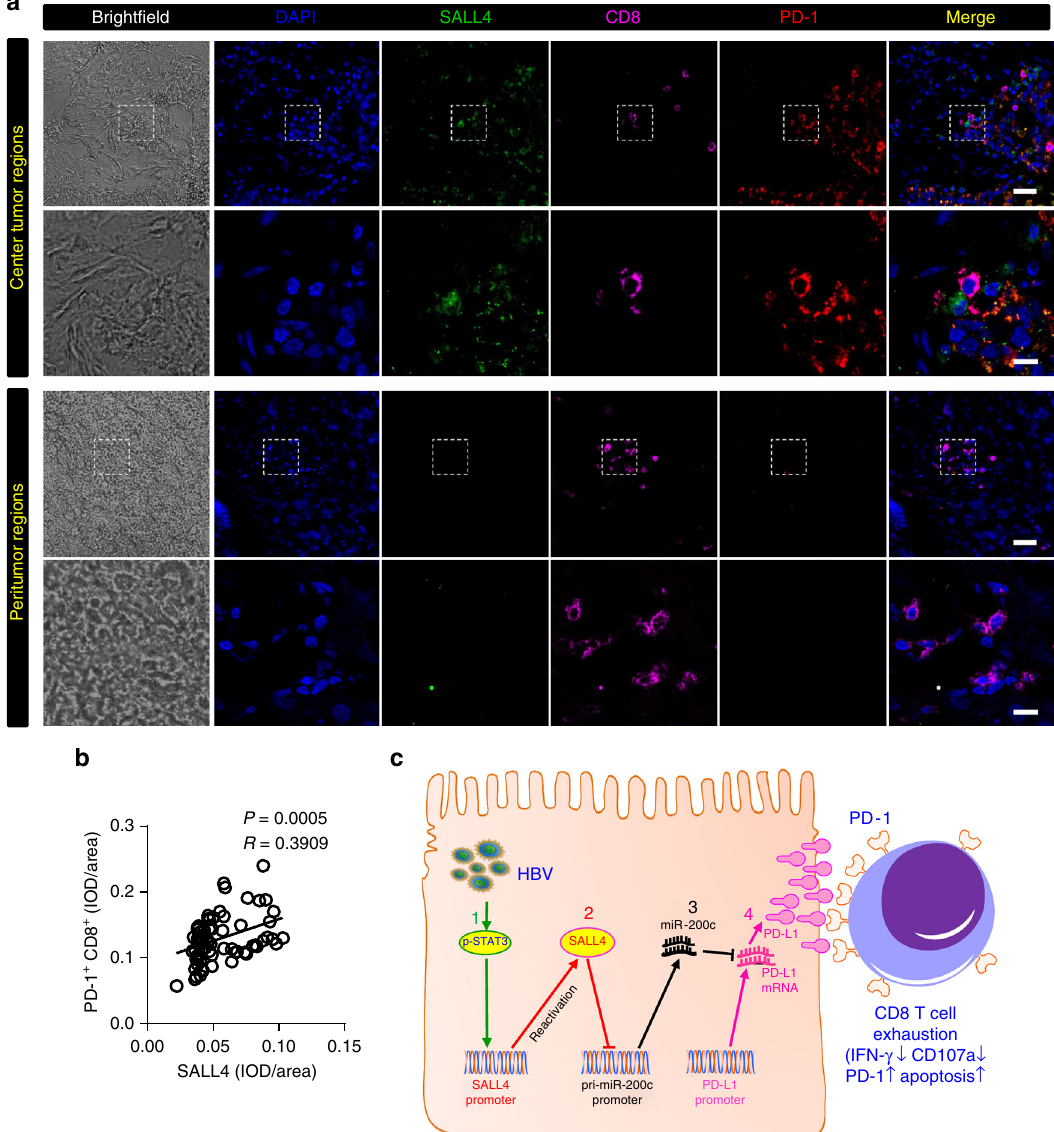
Fig. 9 Positive correlation between SALL4 expression and tumor in fi ltrating PD-1 + CD8 + T cells in HCC. a Confocal immuno fl uorescence images of SALL4 (green), CD8 (magenta) and PD-1 (red) staining in the center tumor (top 2 row) and peritumor (bottom 2 row) regions of HCC. Original magni fi cations: × 20, × 63; scale bar represents 50 μ m and 10 μ m, respectively. b Correlation between the expression of SALL4 and PD-1 + CD8 + cells in the center tumor regions of 75 confocal images from12 fresh tissue samples of HCC patients. Each patient has been taken more than six random perspectives. Pearson ’ s correlation coef fi cients and P values are shown. c The proposed model of HBV-pSTAT3-SALL4-miR-200c-PD-L1-T cell exhaustion axis. miR-200c is an intrinsic regulator to directly inhibit PD-L1 expression; however, HBV could suppress miR-200c transcription via reactivating oncofetal protein SALL4, a transcriptional repressor, up-regulated by HBV-induced STAT3 activation, eventually leading to higher expression of PD-L1 and